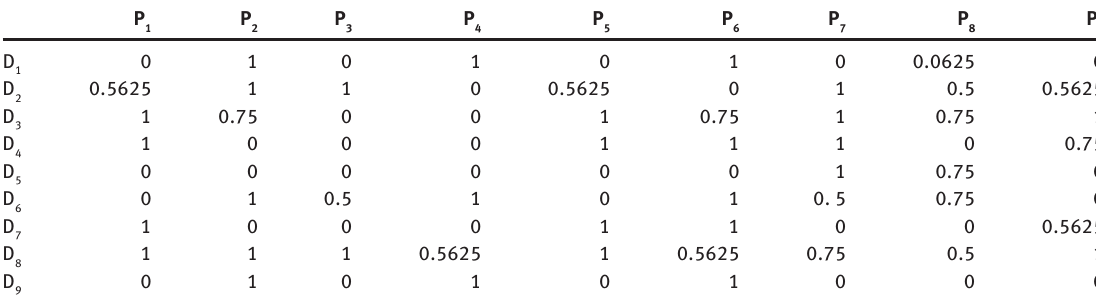
Table 4: Disease-Patient Occurrence Indication Matrix (p × d) (Case Study Example).